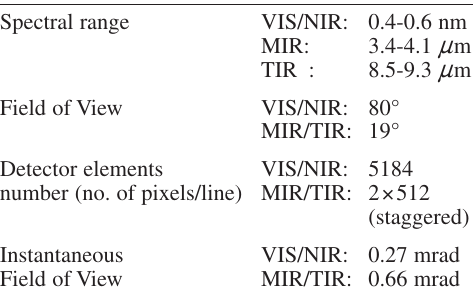
Table III. ABAS technical